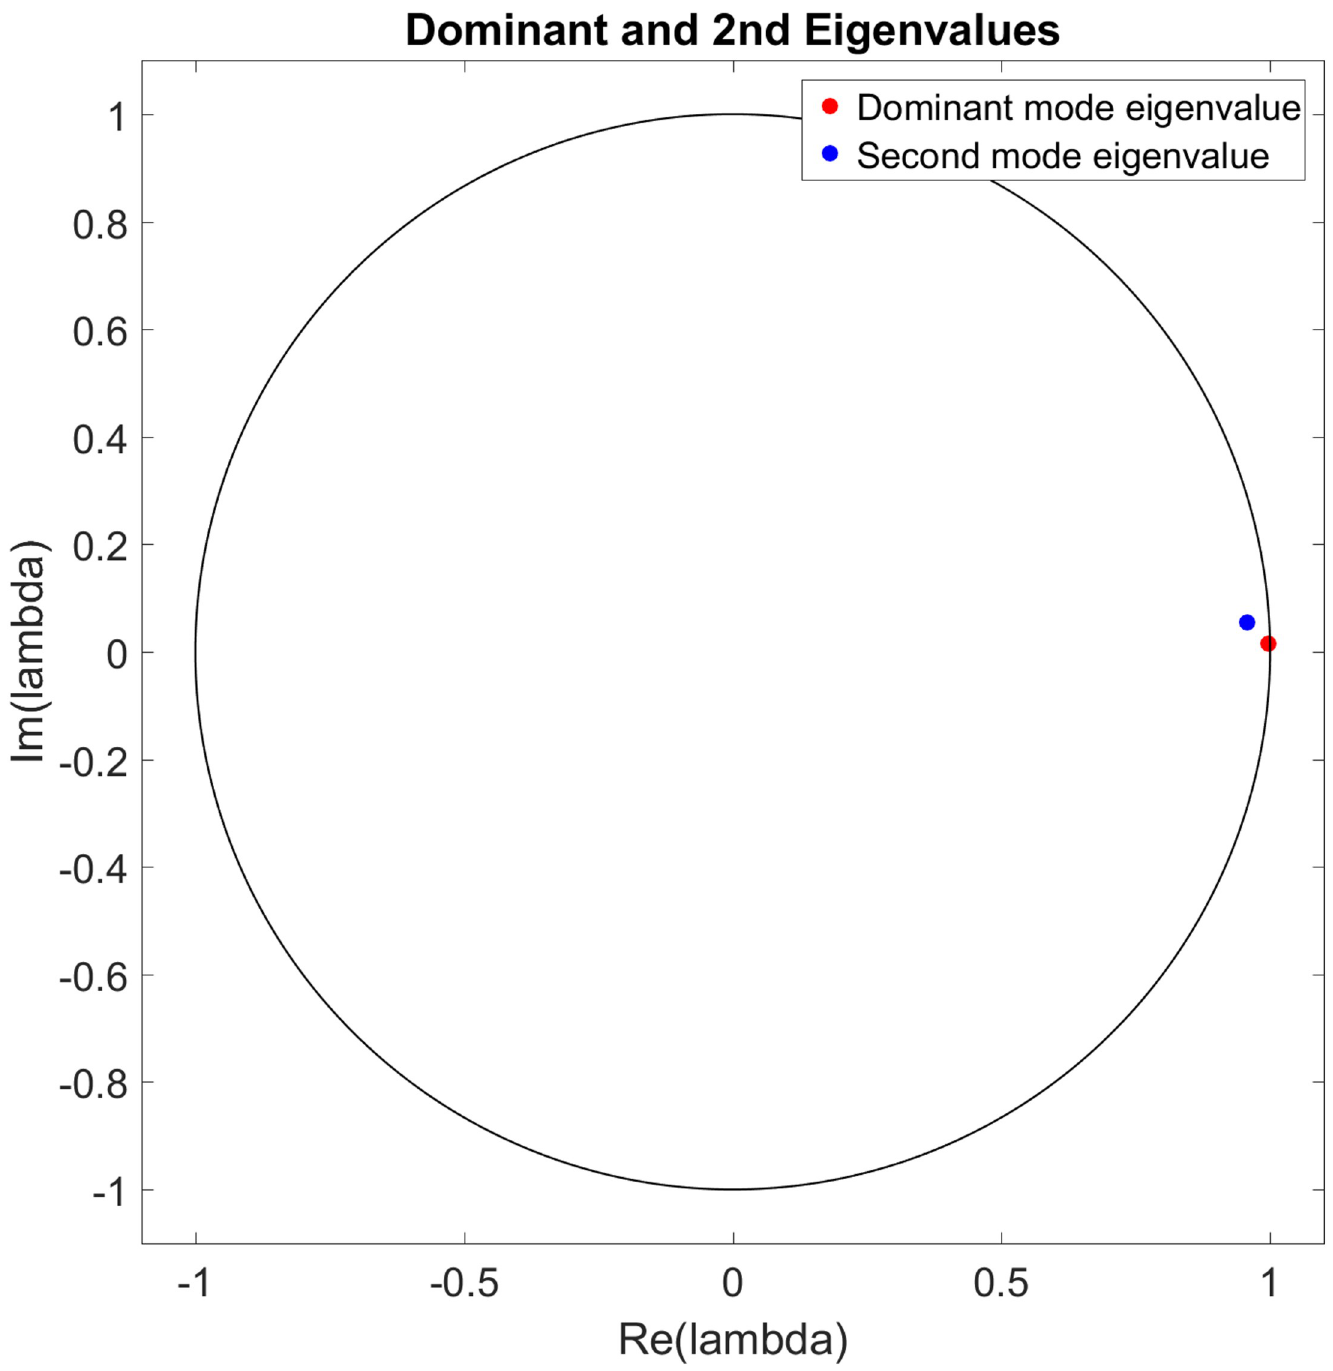
Fig 24. Example eigenvalues of the dominant and second modes from a single simulation for maximum site fuel value of 100 units. The dominant mode eigenvalue is nearly on the unit circle and the real axis, indicating little or no temporal growth/decay or oscillatory behavior, while the second mode eigenvalue is closer to the origin and off of the real axis, indicating long term decay and oscillatory behavior of the associated mode.